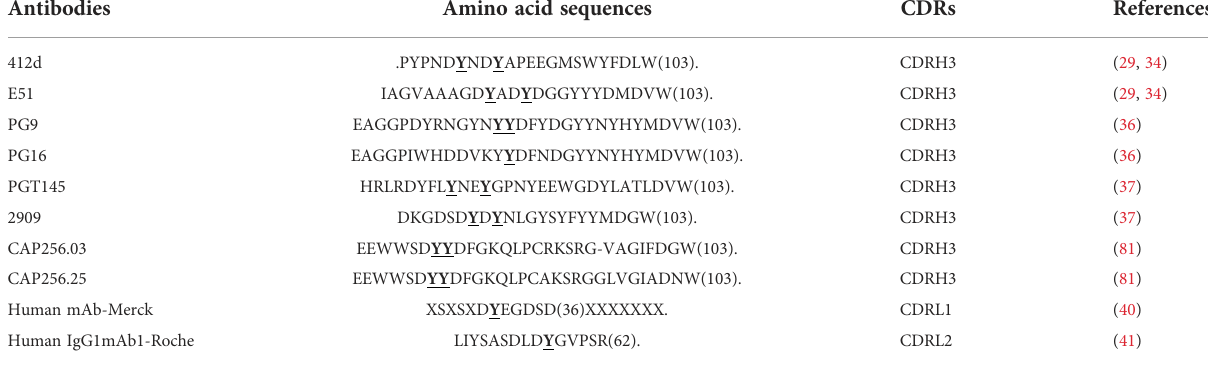
TABLE 1 Summary for sequences and sTyr residues at antibody